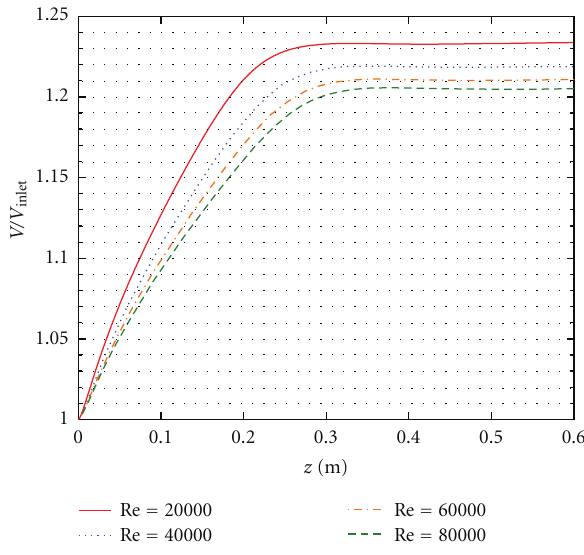
Figure 2: Normalized velocity distributions along the centerline channel for Al 2 O 3 /water 4vol. % at di ff erent Re.